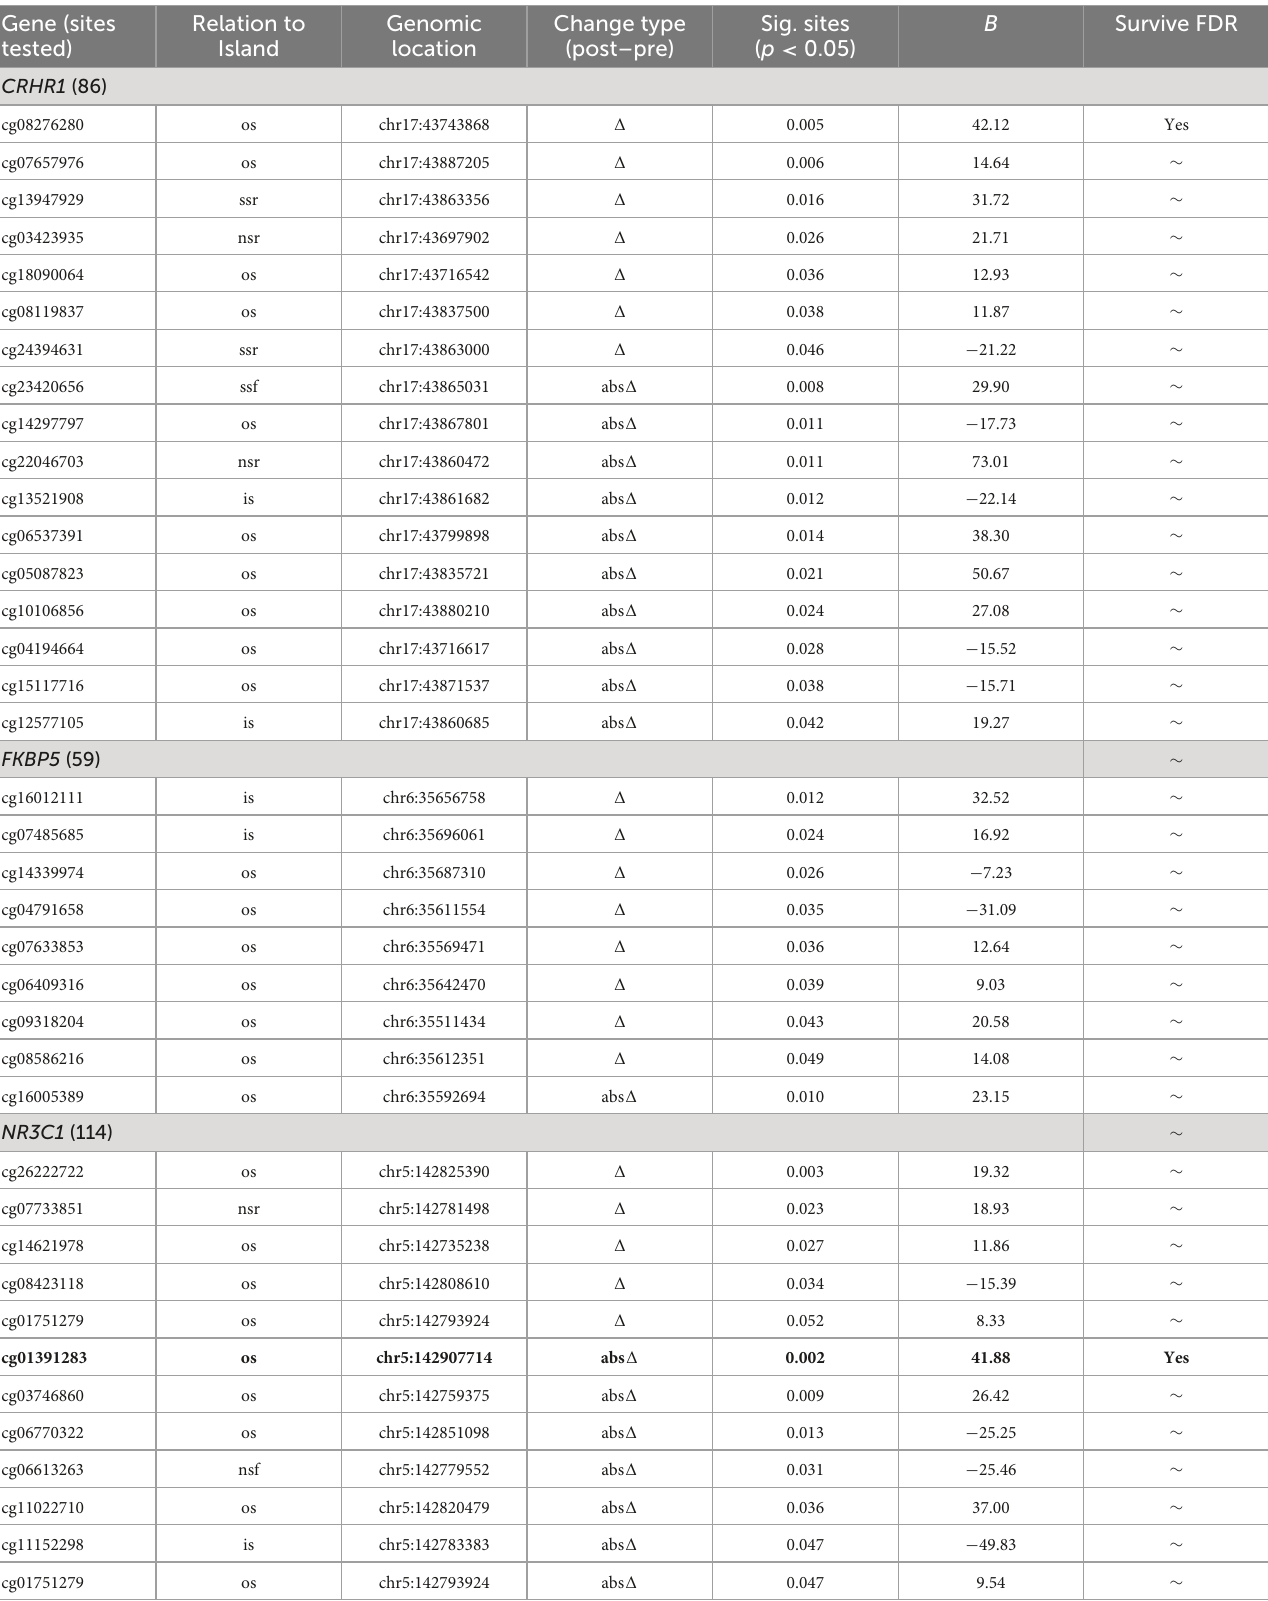
TABLE 2 Change in methylation predicting change in Clinician-Administered PTSD Scale for DSM-5 (CAPS-5). Gene (sites Relation to tested)